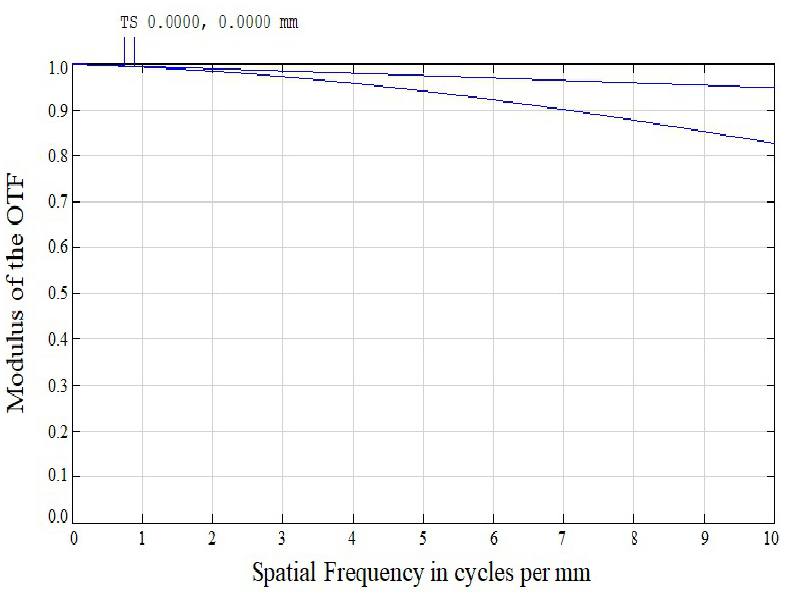
Figure 3. Evolution of the modulation transfer function (MTF) curve at 575 nm.